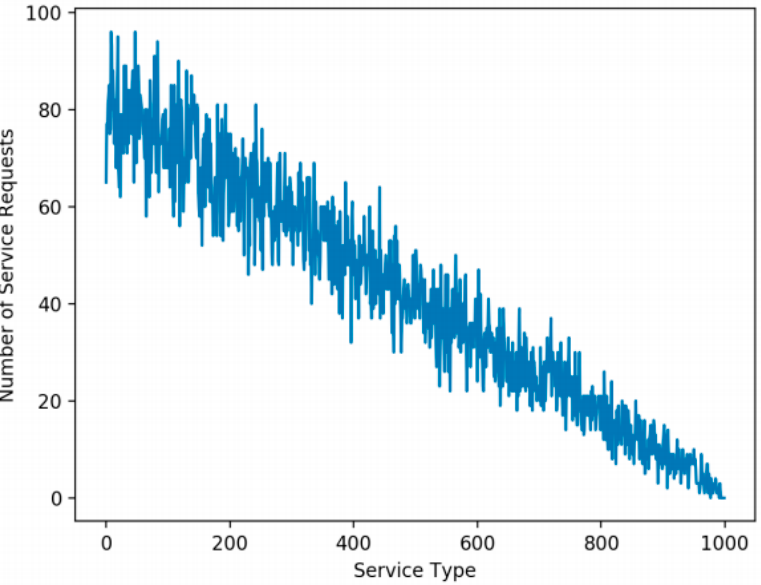
Figure 12. The U distribution case with 140,525 service demands for 1000 service types.